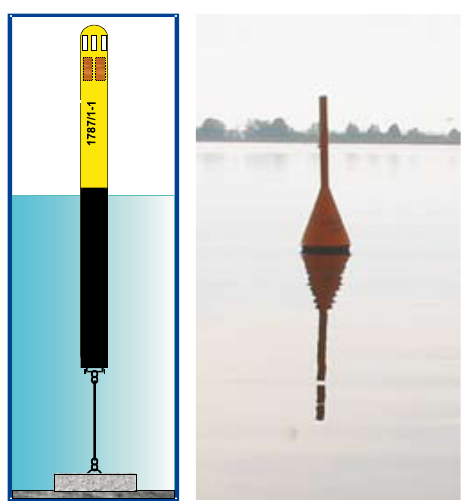
Fig. 3. Float (buoy) construction drawing and float marking protection zone in the lake